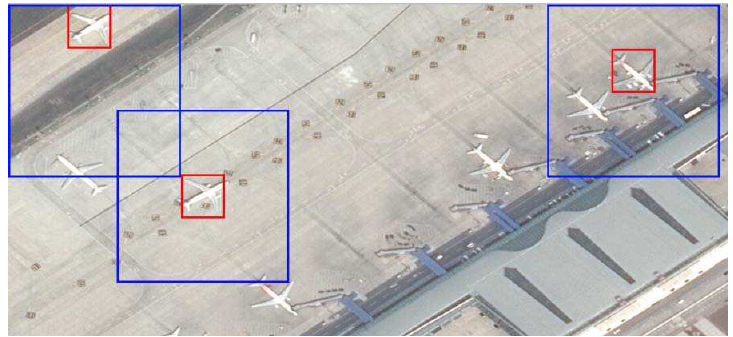
Figure 12. The definition of the context scene for the candidate region.